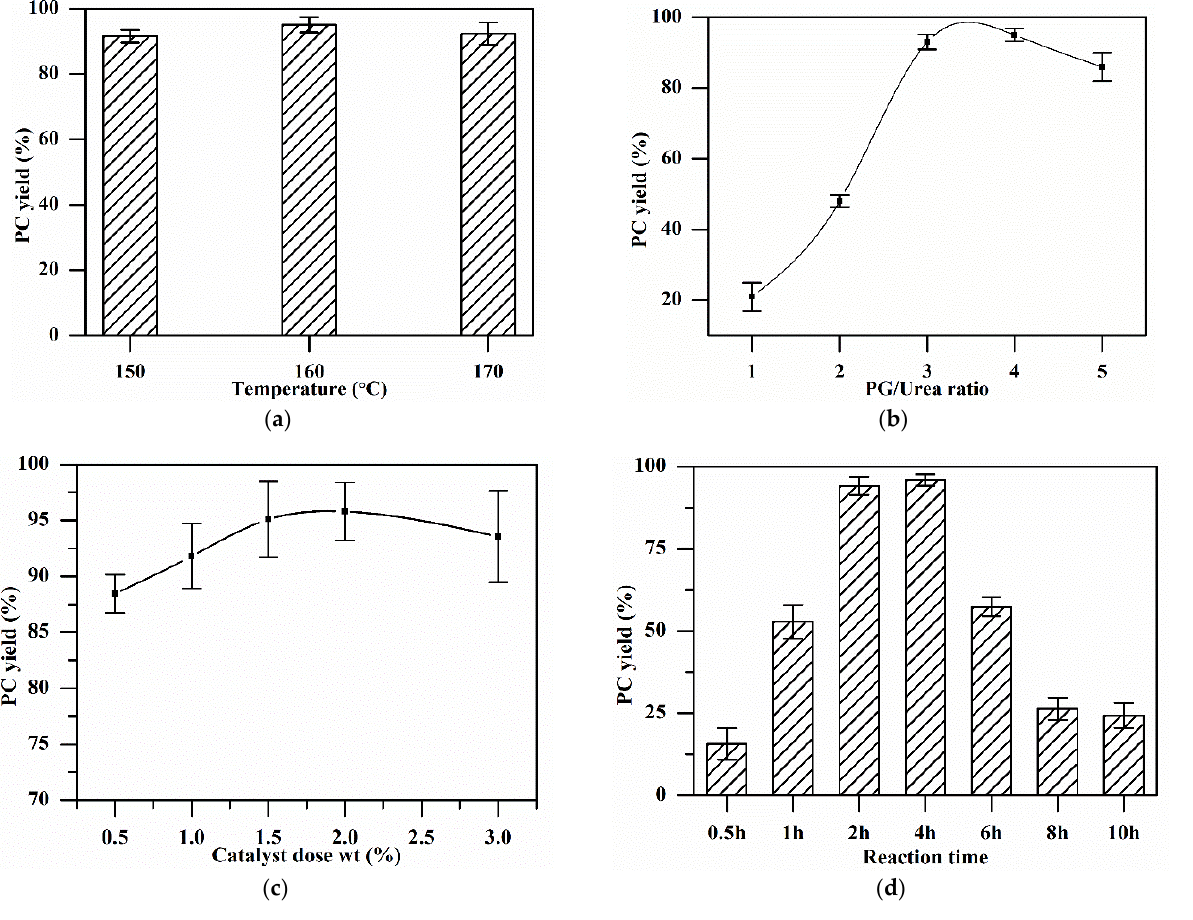
Figure 5. Effect of various parameters on the PC yield: ( a ) Reaction temperature: catalyst 1 wt.%, reaction time 3 h, PG/urea ratio 4:1. ( b ) PG/urea ratio: catalyst 1 wt.%, reaction time 3 h, reaction temperature 160 °C. ( c ) Catalyst dosage: reaction time 3 h, PG/urea ratio 3:1, reaction temperature 160 °C. ( d ) Reaction time: catalyst 2 wt.%, PG/urea ratio 3:1, reaction temperature 160 °C.